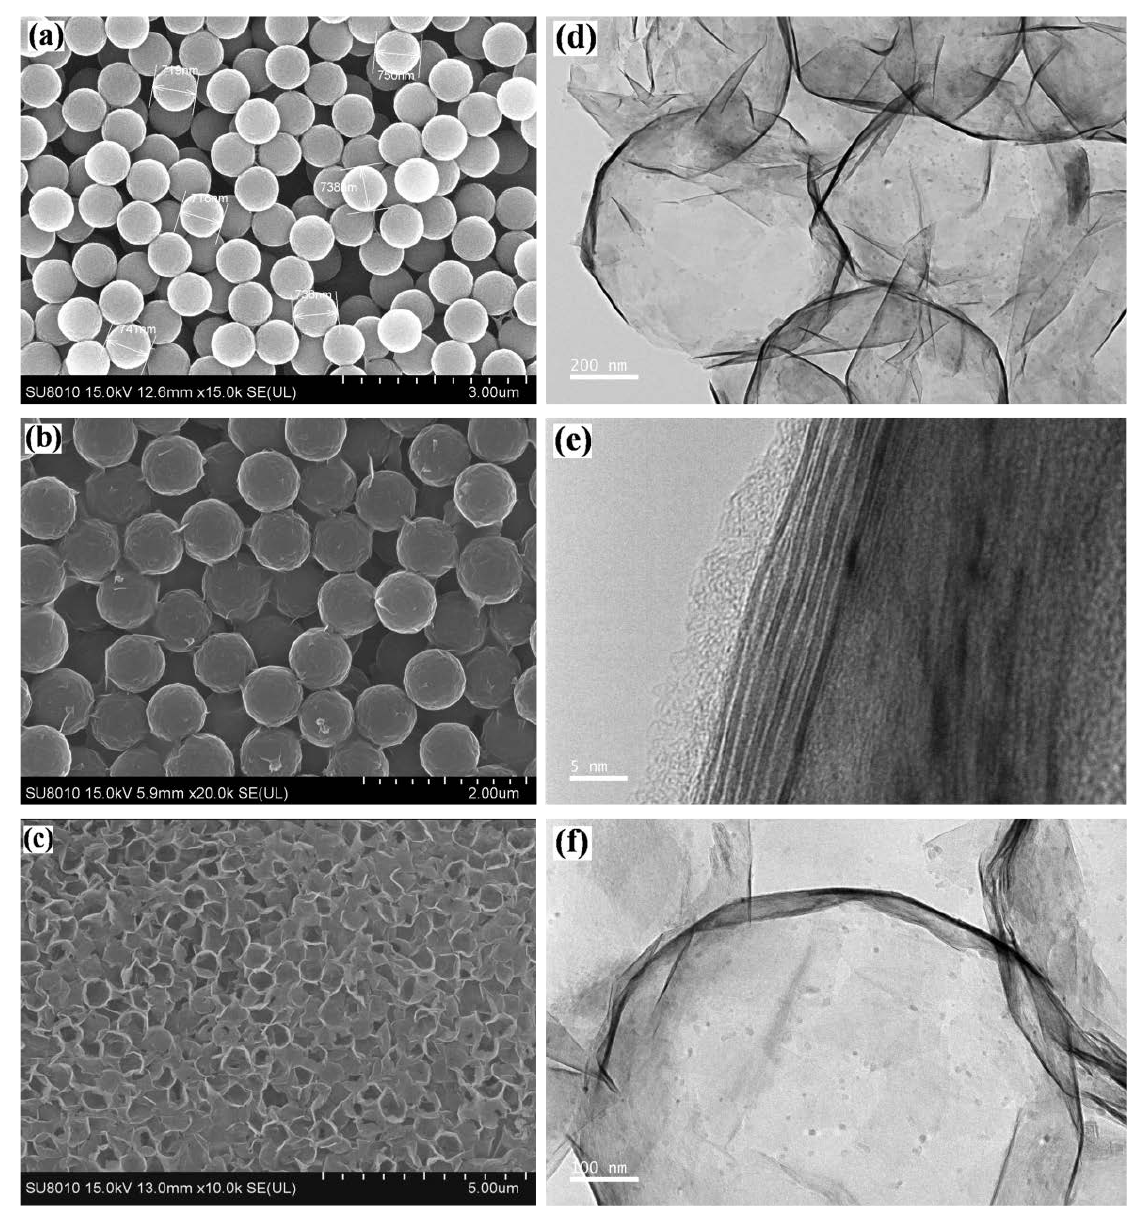
Figure 1. SEM images of ( a ) CPS and ( b ) CPS@MXene spheres, and ( c ) the as-prepared HSMX. ( d – f ) TEM images of HSMX and its spherical wall.